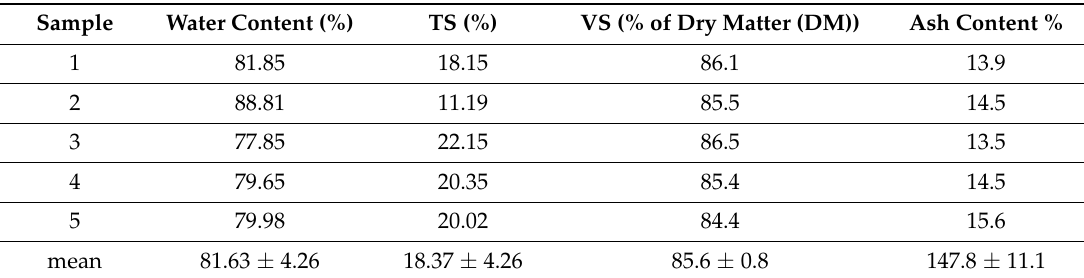
Table 1. The total solid (TS) and volatile solid (VS) content of the organic fraction of municipal solid waste (OFMSW)